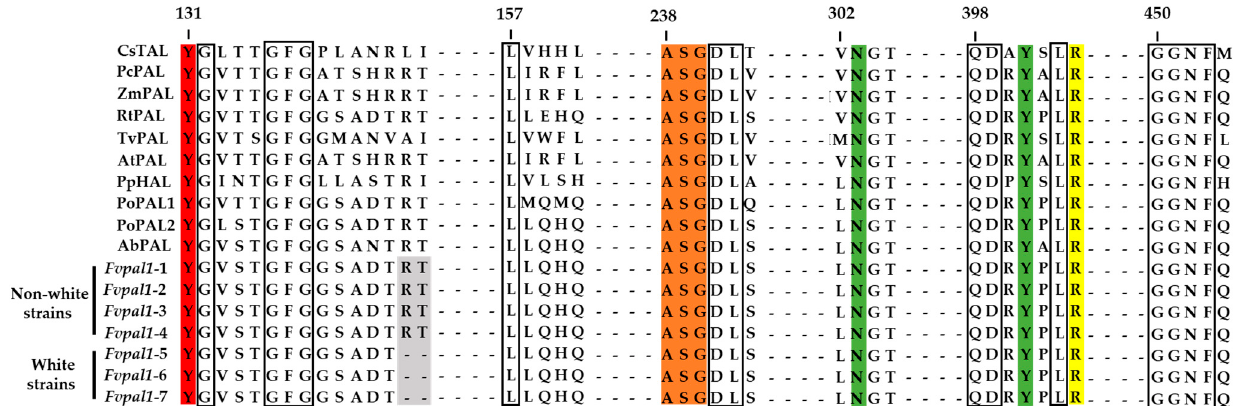
Figure 6. Alignment of the highly conserved domains of phenylalanine/tyrosine/histidine ammonia ‐ lyase amino acids. Red: catalytically essential tyrosine residue, orange: the MIO forming amino acid triad, green: amino acid stabilizing MIO group, yellow: arginine responsible for binding the carboxylic group of the substrate, gray: variation site (arginine and threonine) of F. velutipes , boxes: other conserved catalytic and binding residues. Cereibacter sphaeroides TAL (CsTAL, UniProtKB ID; Q3IWB0), Petroselinum crispum PAL (PcPAL, UniProtKB ID; P24481), Zea mays PAL (ZmPAL, UniPro- tKB ID; C0HJ40), Rhodosporidium toruloides PAL (RtPAL, UniProtKB ID; P11544), Trichormus